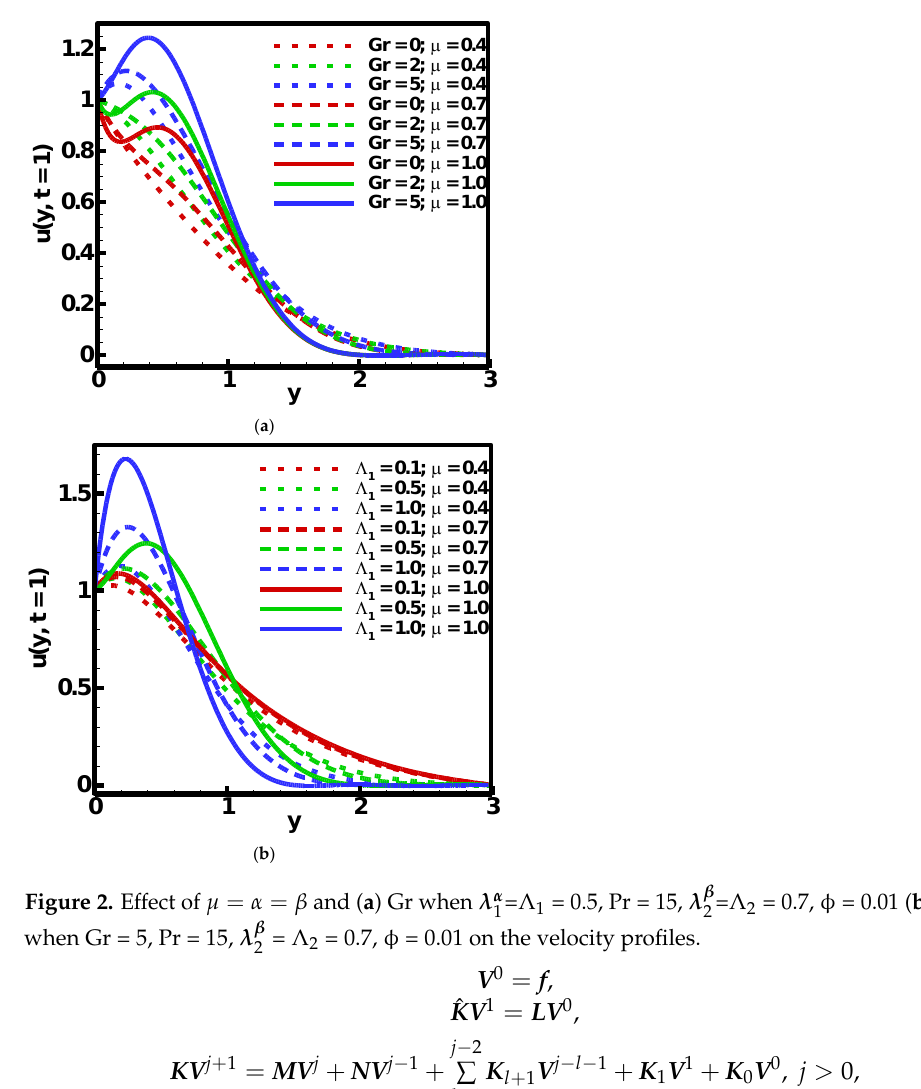
where the vector f is generated through the initial conditions associated with the proposed problem.